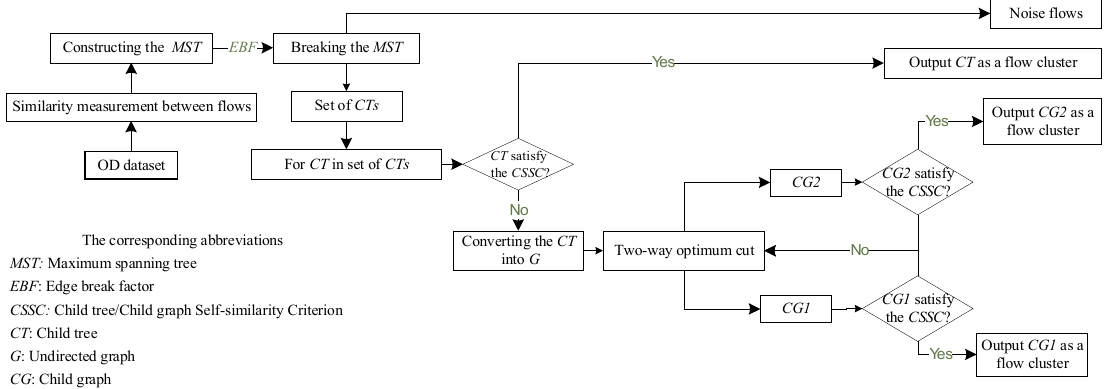
Figure 1. The whole process of Tree-based and Optimum Cut-based Origin-Destination Flow Clustering (TOCOFC).